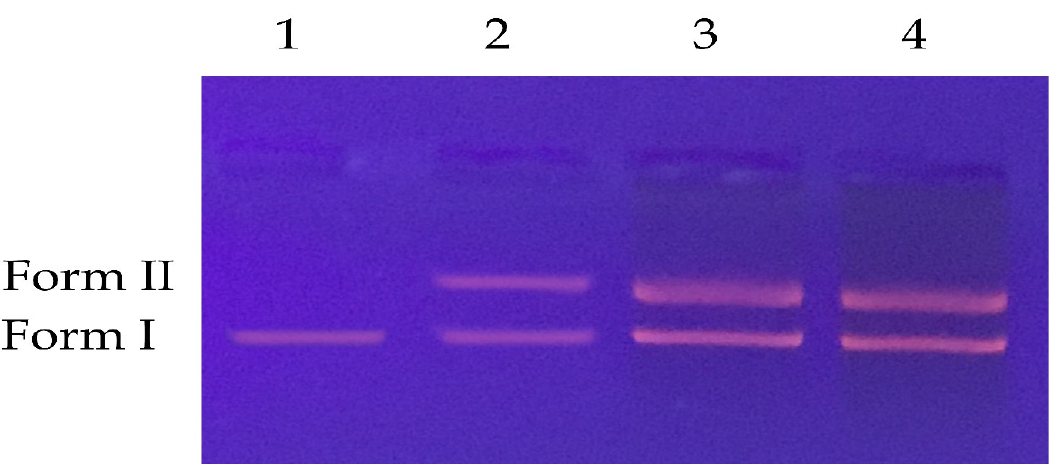
Figure 4. DNA cleavage activity of synthesized γ‐ Fe 2 O 3 ‐ CA ‐ Leu ‐ Gly ‐ PDX. Lane 1, pBR 322 DNA; Lane 2, pBR 322 DNA + 50 mg/L of γ‐ Fe 2 O 3 ‐ CA ‐ Leu ‐ Gly ‐ PDX; Lane 3, pBR 322 DNA + 100 mg/L of γ‐ Fe 2 O 3 ‐ CA ‐ Leu ‐ Gly ‐ PDX; Lane 4, pBR 322 DNA + 200 mg/L of γ‐ Fe 2 O 3 ‐ CA ‐ Leu ‐ Gly ‐ PDX.